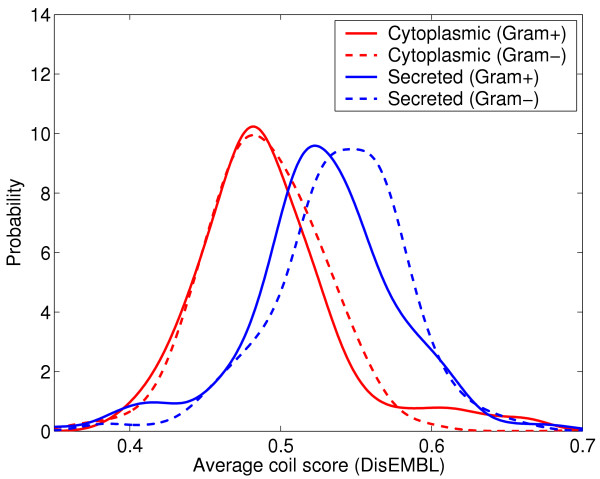
Bacterial secreted proteins are more disordered in structure than cytoplasmic proteins. The predicted number of coils (average per residue) by DisEMBL is higher for secreted proteins than for cytoplasmic ones. The tendency also holds for the two other measures of disorder predicted by DisEMBL (not shown).